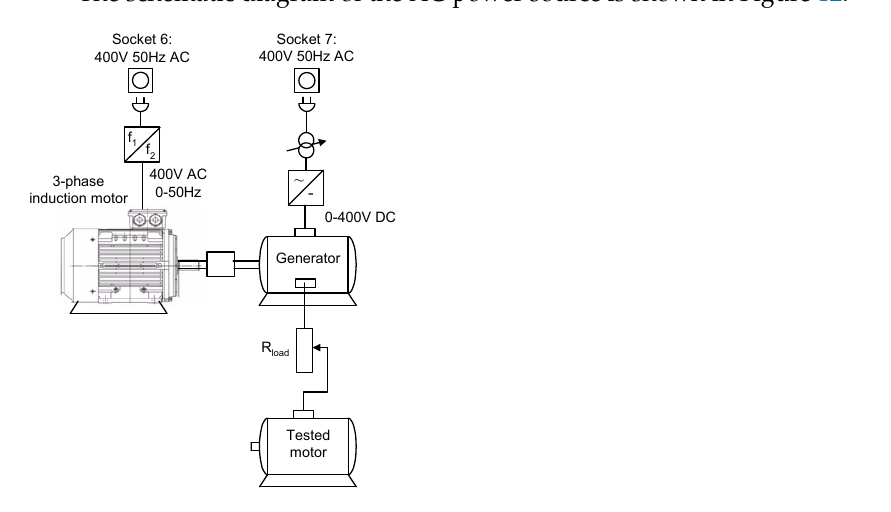
Figure 12. Schematic diagram of the AC power source with variable voltage and